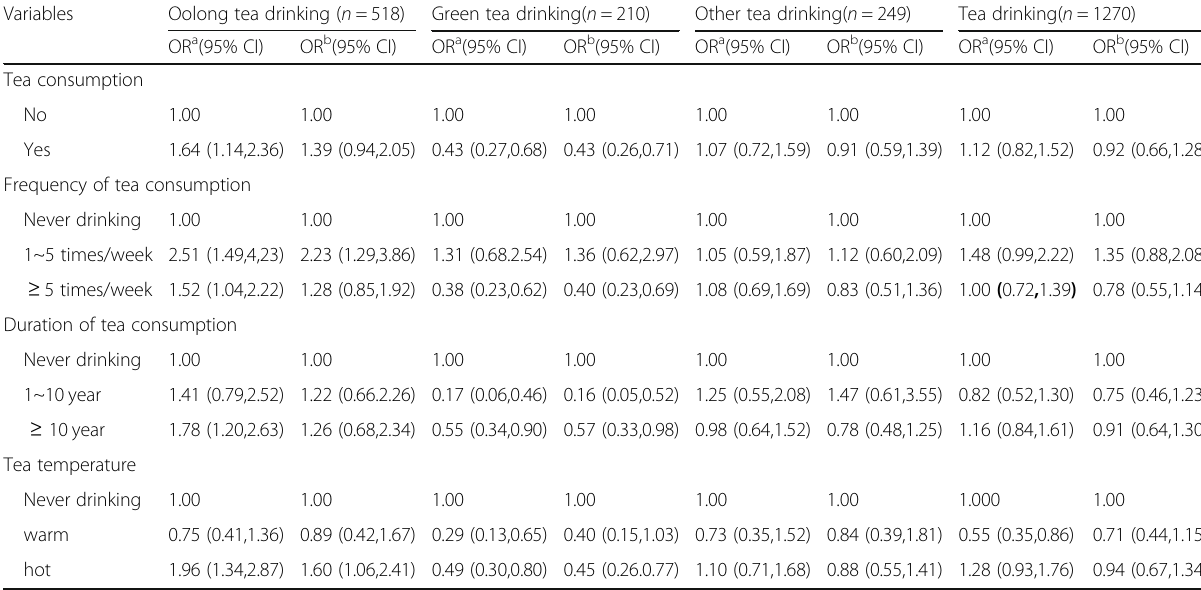
Table 2 Tea Drinking Habits and Odds Ratios (95% Cl ) among Cases and Controls Variables Oolong tea drinking ( n =